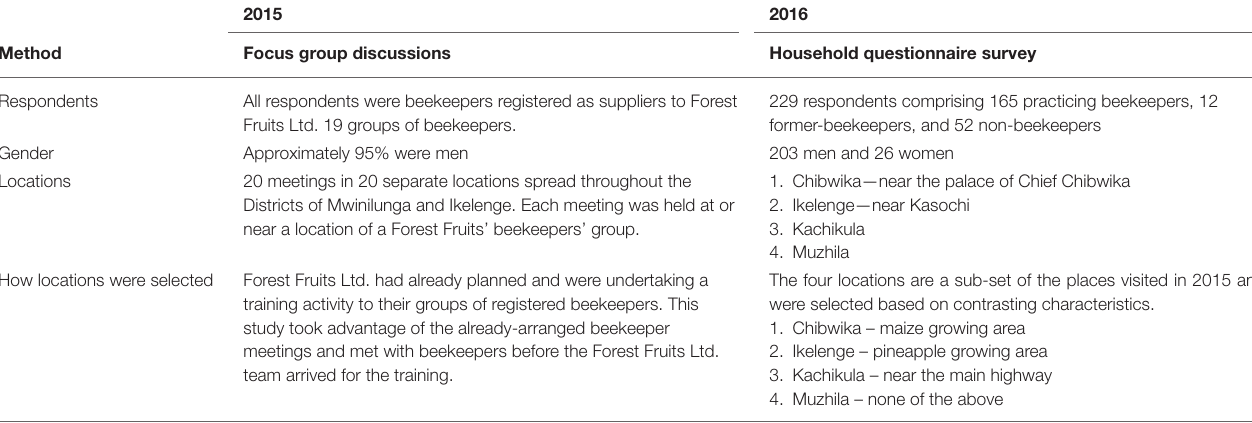
TABLE 1 | Overview of research locations visited in 2015 and